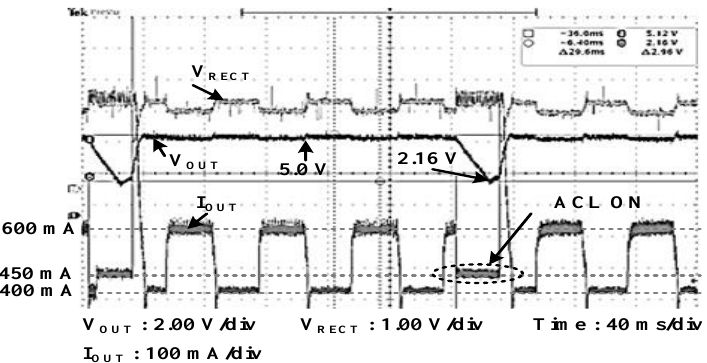
Figure 12. Measured waveform of multi-feedback LDO (MF-LDO).